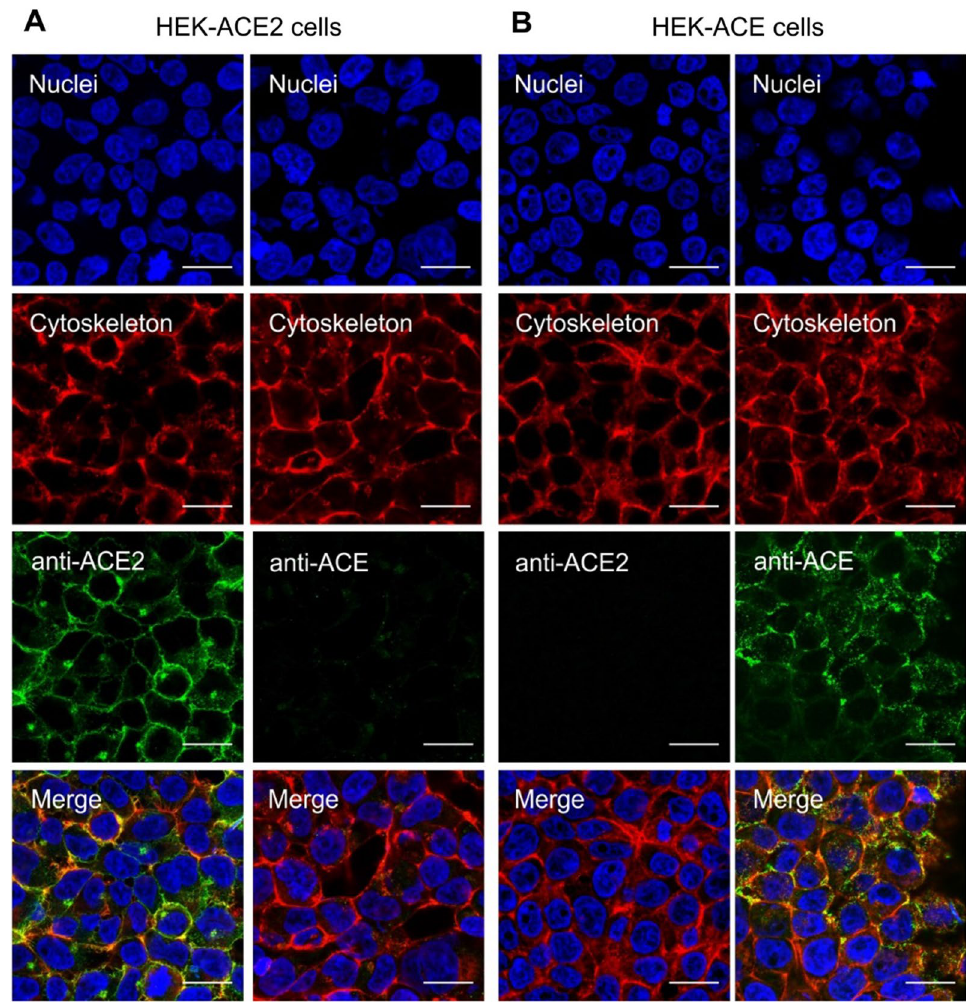
Fig. 2 Immunofluorescence microscopy images of A HEK‑ACE2 and B HEK‑ACE cells. Nuclei were stained with DAPI (blue); F‑actin of the cytoskeleton was stained with fluorescent phalloidin (red); ACE2 and ACE were stained with a fluorophore‑conjugated secondary antibody (green) after incubation with anti‑ACE2 and anti‑ACE antibodies; The merged images show the overlay of all stainings. The scale bar corresponds to 20